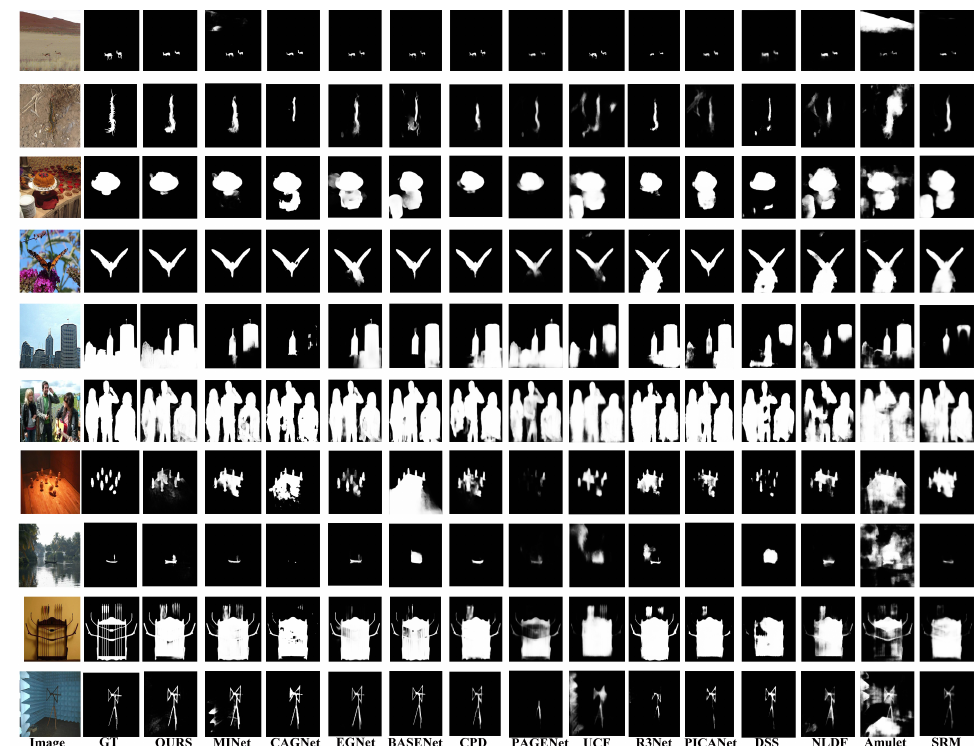
Figure 8. Visual comparisons with state-of-the-art methods in various circumstances: low contrast, complicated scene, large objects, small objects, and multiple